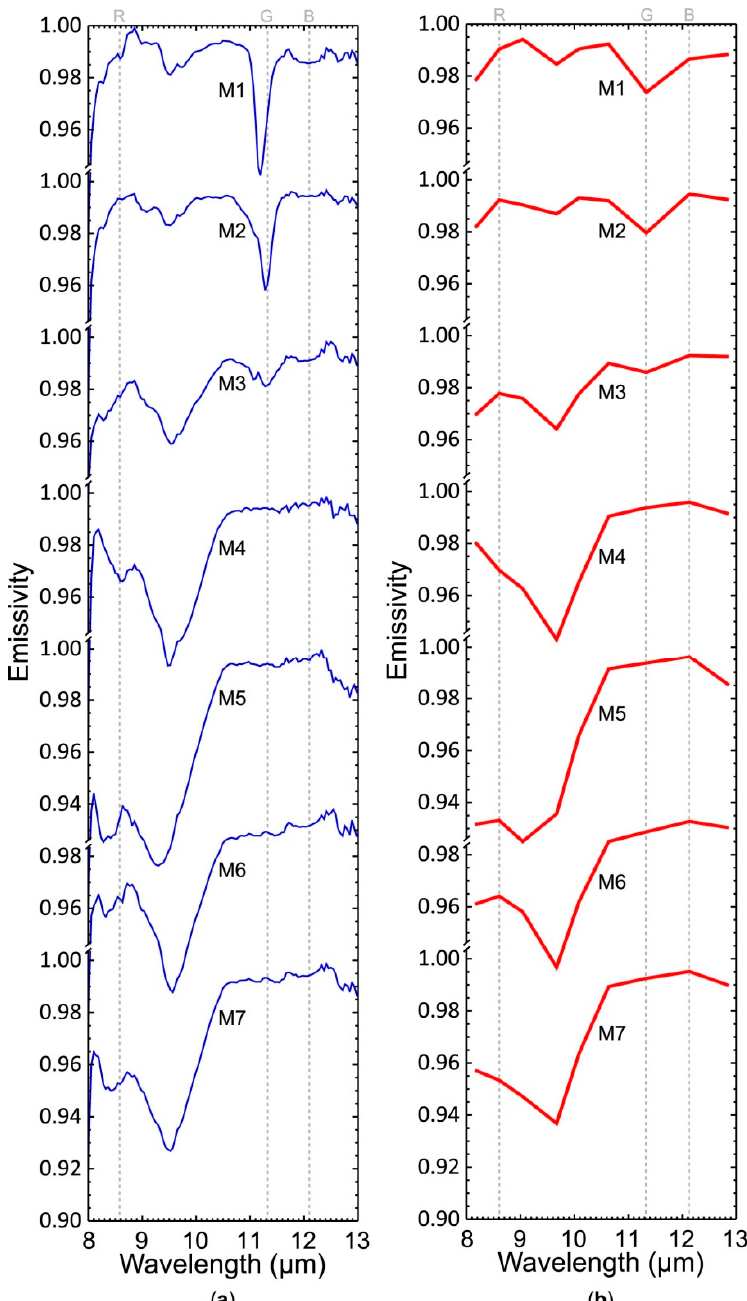
Figure 17. Mean emissivity spectra of regions of interest (ROI) M1-M7 from the Mako data at: ( a ) Mako native spectral resolution; ( b ) convolved to the spectral response functions of the MODIS/ASTER Airborne Simulator (MASTER) longwave infrared bands. See Figure 16 for ROI locations; gray dashed lines indicate band positions displayed as red (R), green (G), and blue (B) in Figure 16.